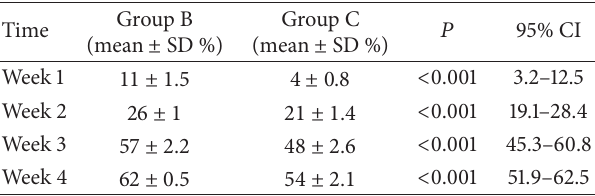
Table 1: Mean necrotic areas in kidneys in